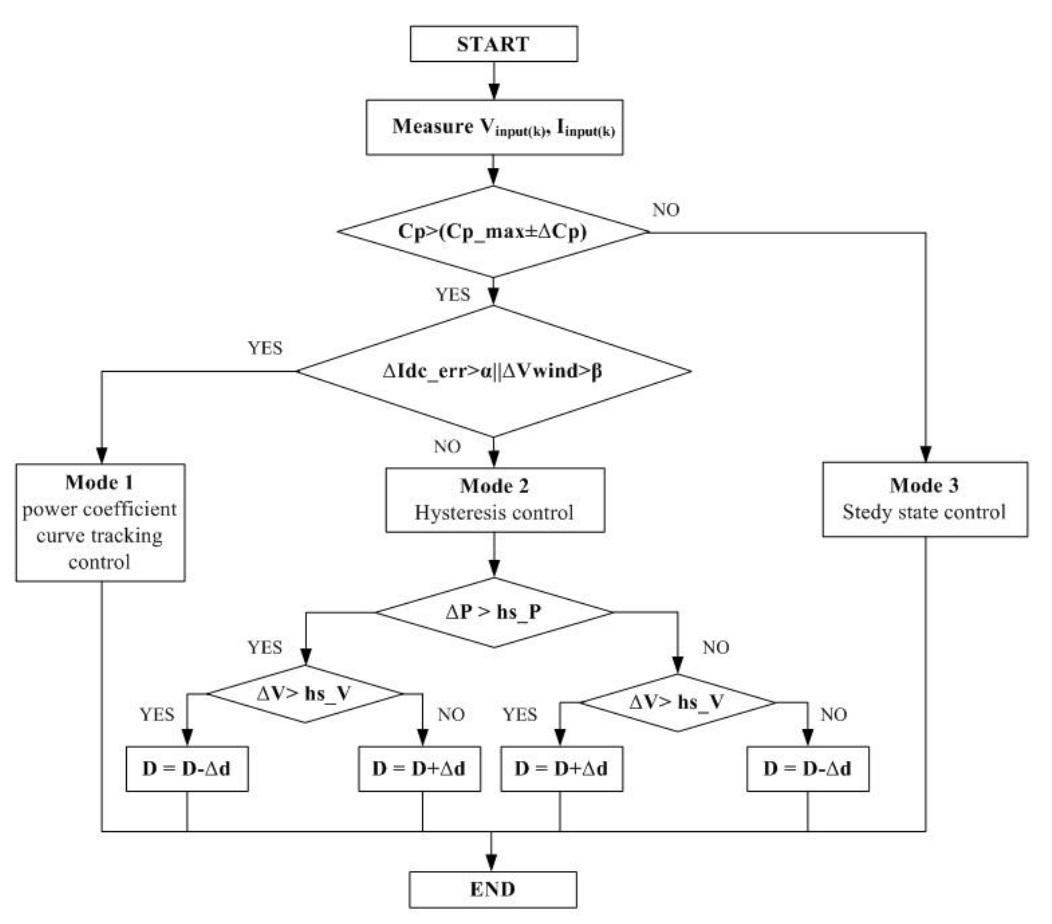
Figure 8. Flow chart of the proposed MPPT method.